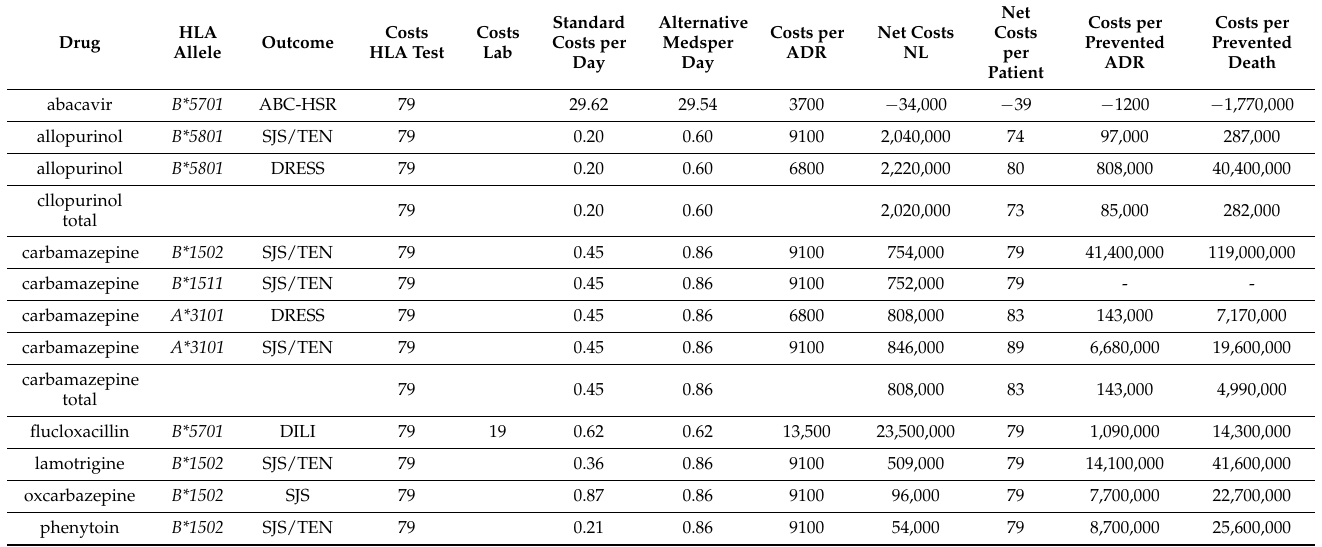
Table 6. Cost-effectiveness model parameters and results (all in